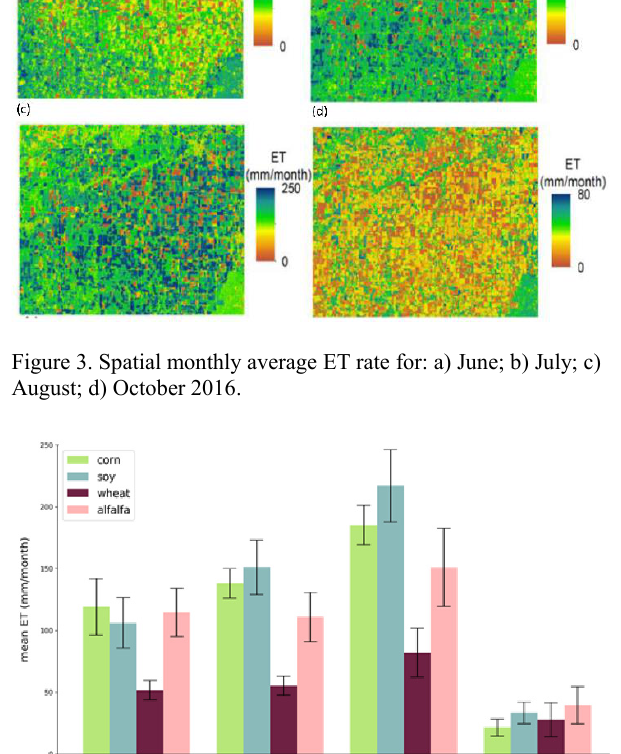
Figure 2. Input data to BEPS: a) Land cover; b) AWHC c) EVI d) LAI